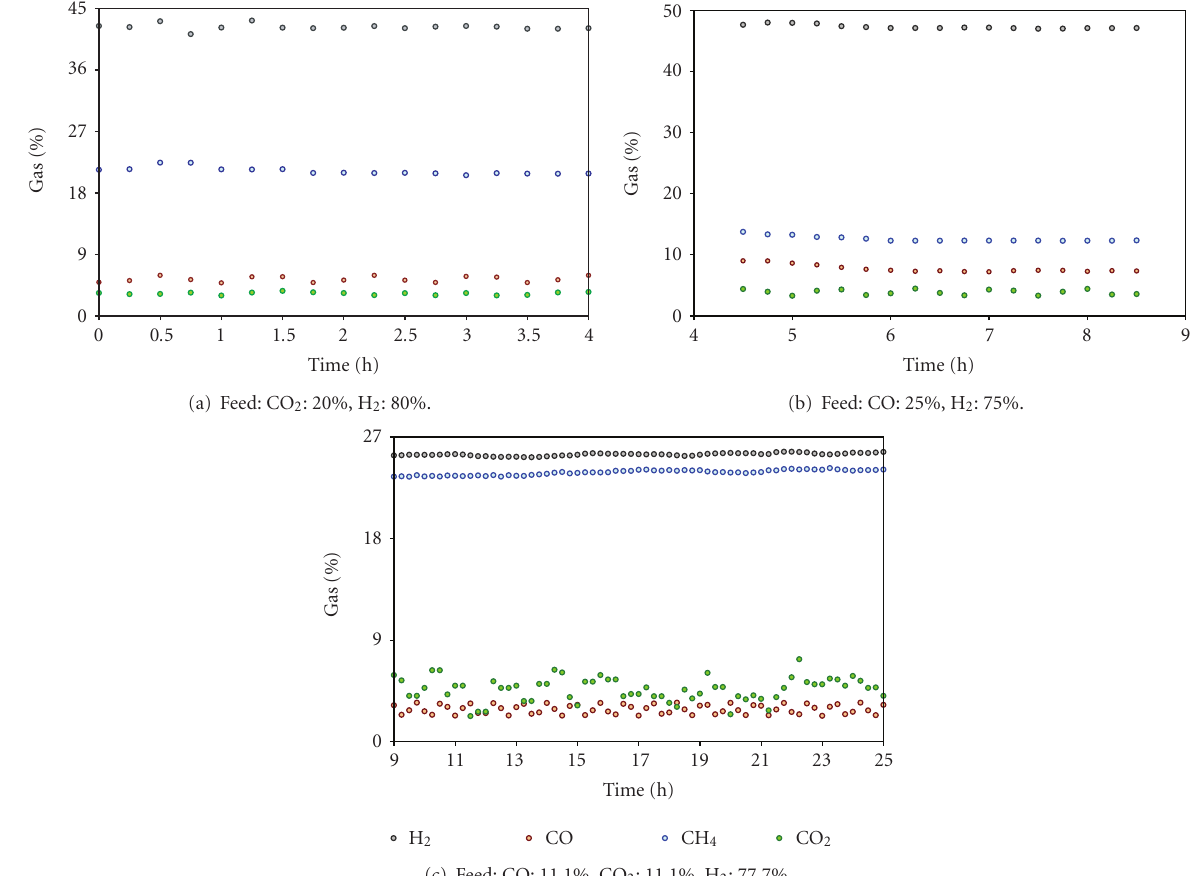
Figure 15: Evidence of the proposed in-situ methanation of carbon monoxide and carbon dioxide by hydrogen as per reactions (7a)–(7c) on the Pd-supported catalyst developed in this work.